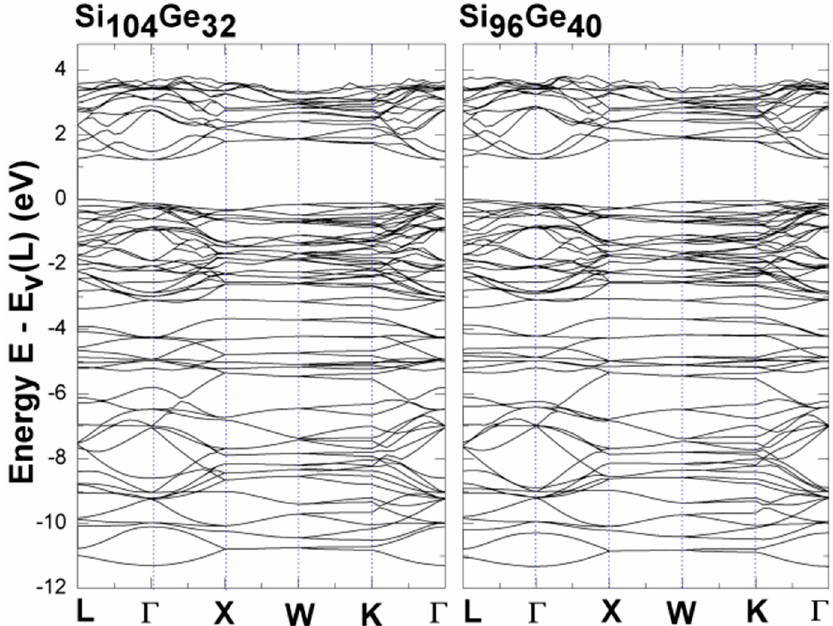
Figure 2. Local density approximation (LDA)-determined electronic band structures of Si 104 Ge 32